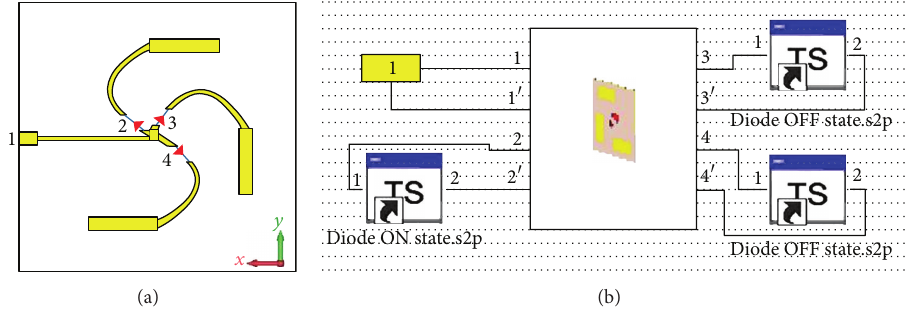
Figure 3: Schematic diagram of the TSB implementation to the antenna. (a) Port creation of the antenna design. (b) TSB attached to the antenna.